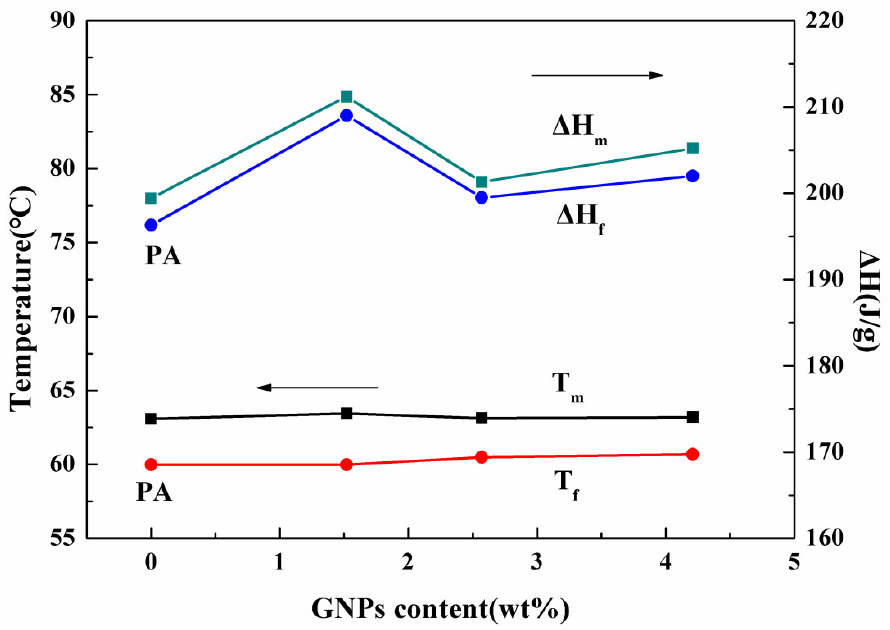
Figure 6. The phase-change temperature and latent heat of PA and PA/HGA with different GNPs